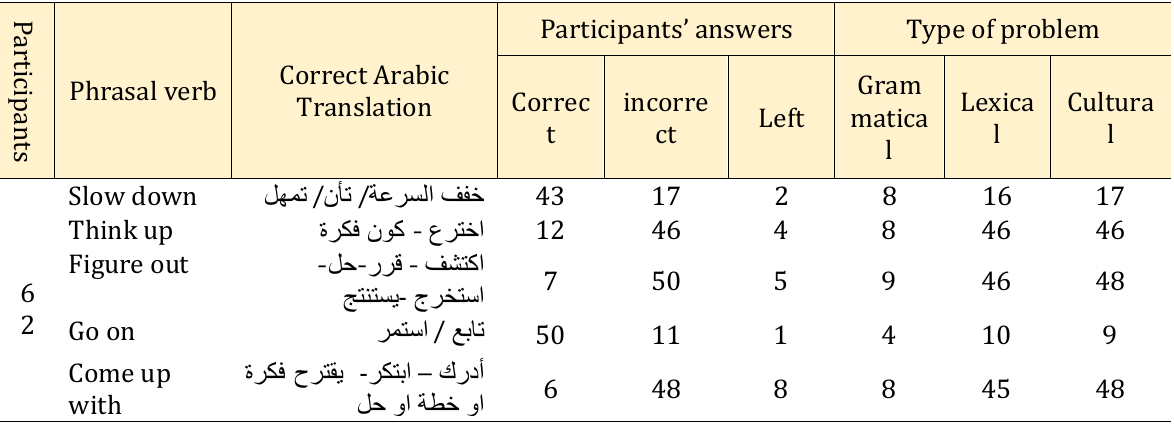
Table 3. Analyzing Students’ Answers in Translating English Phrasal